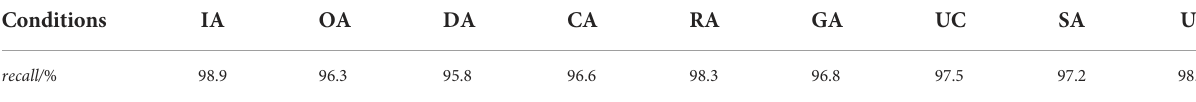
TABLE 3 Detection results of apples under different